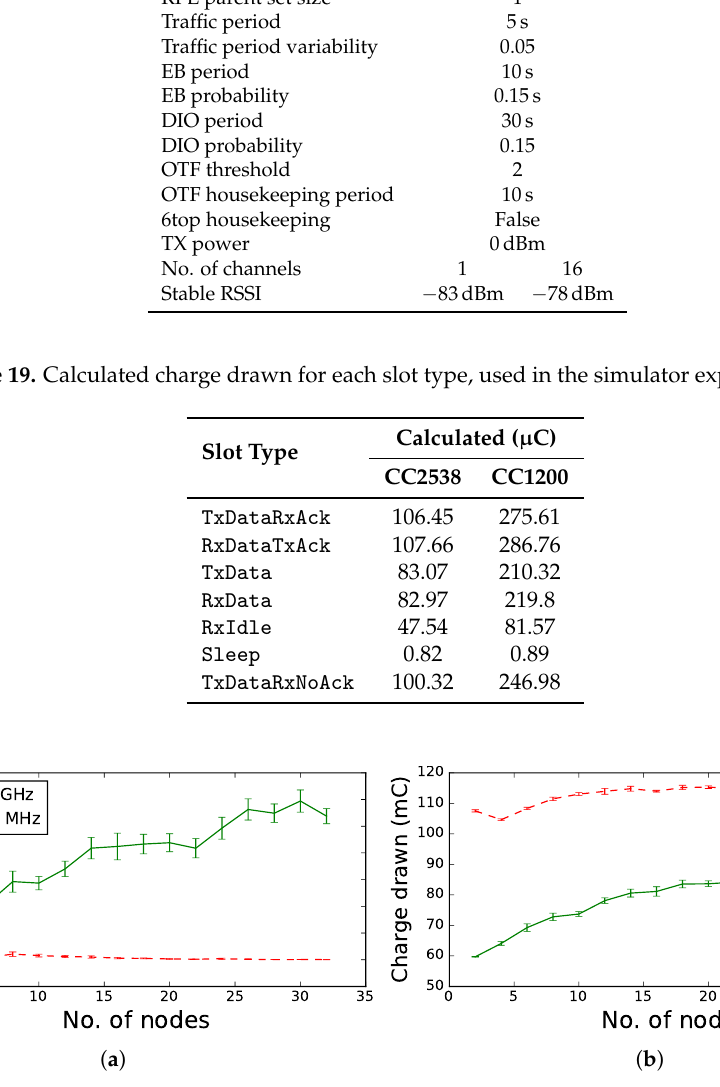
Figure 10. Total consumed charge per node and average hop count for 868MHz and 2.4GHz frequency communication in a random topology as a function of the number of nodes. ( a ) Average hop count; ( b ) total energy consumed per